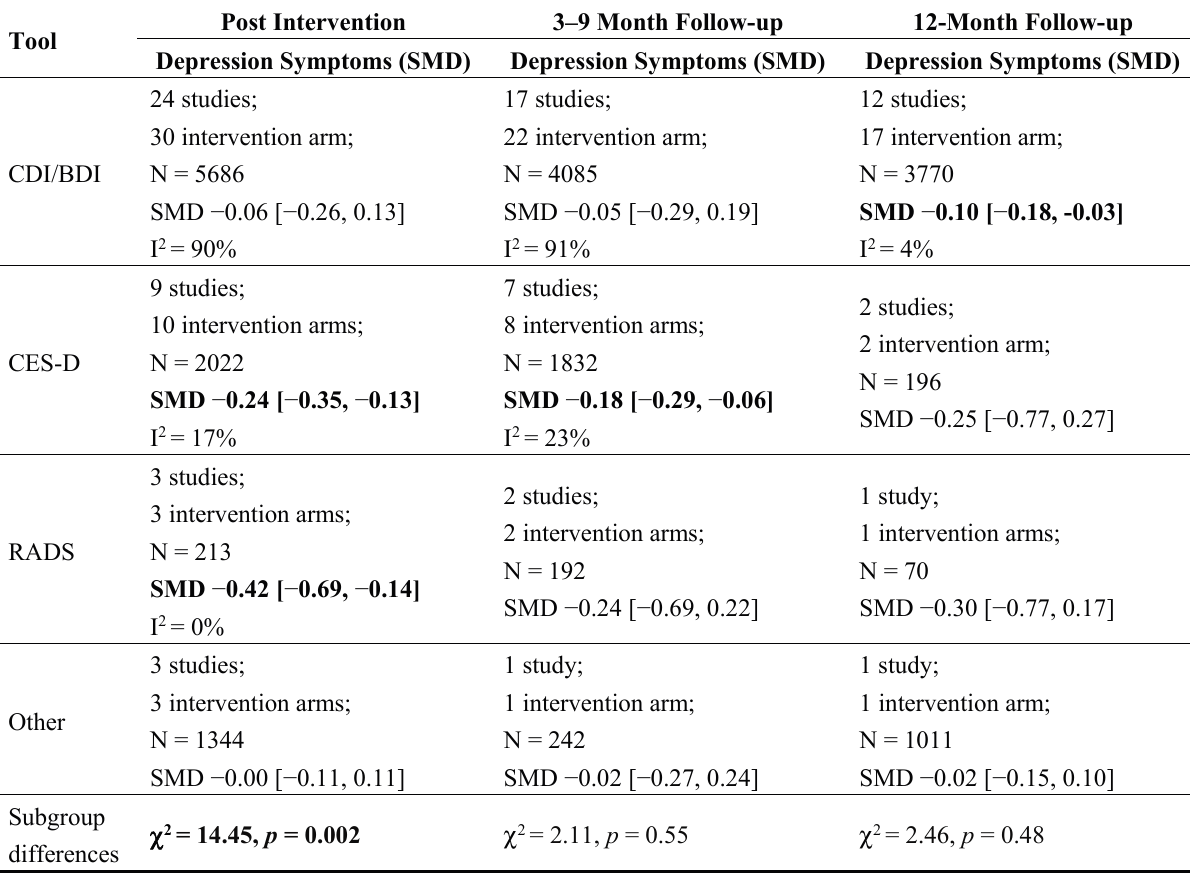
Table 8. Summary of meta-analysis results for approach to prevention programs analysed by the outcome measurement tool